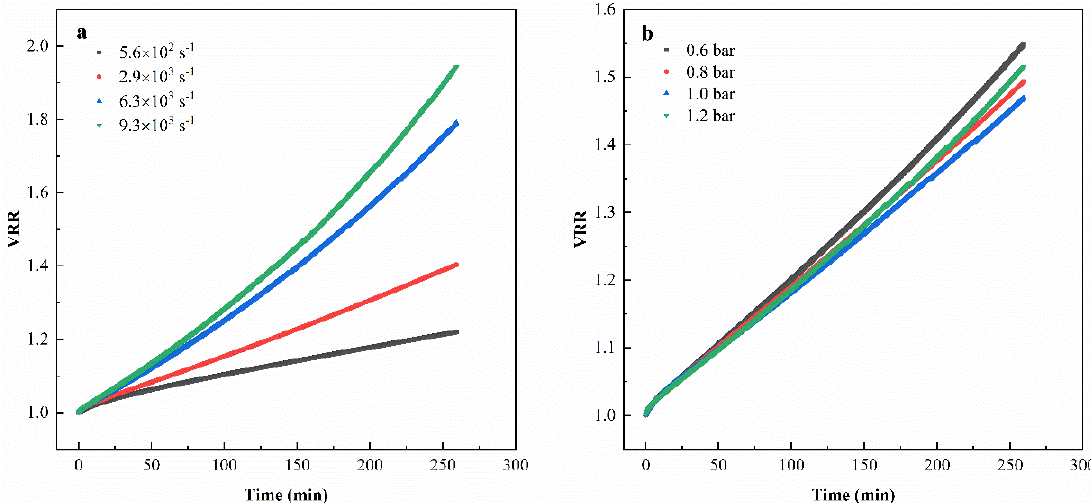
Figure 5. The trend of volume reduction rate (VRR) of tanning wastewater ultrafiltration with time under different operating conditions: ( a ) different shear rates (PVDF, TMP = 1.0 bar, 20 ◦ C); ( b ) different TMPs (PVDF, shear rate = 2.9 × 10 3 · s − 1 , 20 ◦ C).